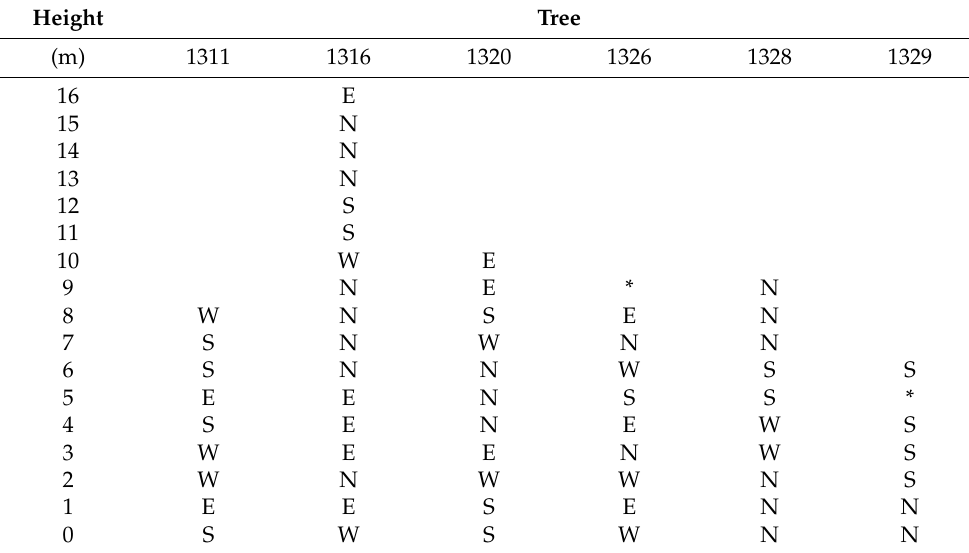
Table 2. The cardinal direction having greatest radial width from pith to cambium at each trunk height of each of the six trees. Height Tree (m)